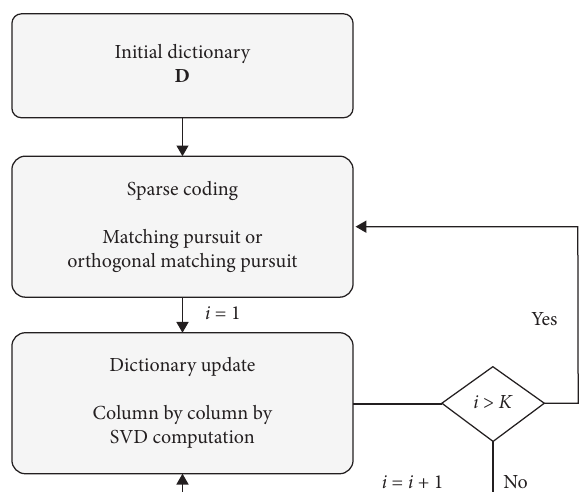
Figure 2: The KSVD algorithm consists of the sparse coding and dictionary update stages, where i and K represent the i th iteration and the number of dictionary atoms, respectively. Sparse coding stage: apply the pursuit algorithms to solve coefficient vectors for each signal while fixing D . Dictionary update stage: the dictionary D is updated column by column through the SVD. The two stages are iteratively performed until convergence. More details about this algorithm can be found in